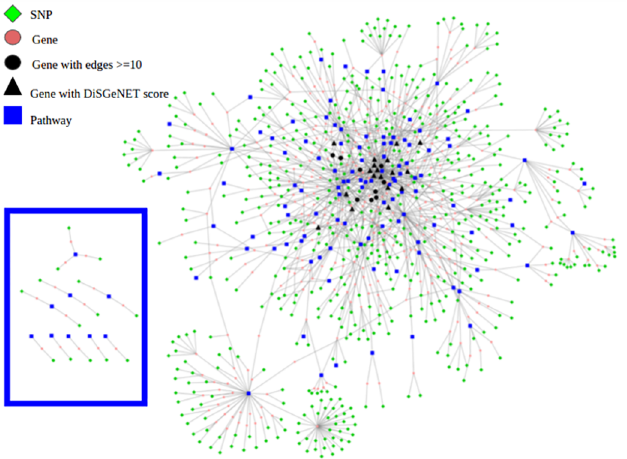
Fig 2. SNP-gene-pathway network. The network displays 580 SNPs (green diamonds) located in the selected region for 365 genes (circles) present in 117 pathway clusters (blue squares). Black symbols indicate genes with ten or more connections to pathway clusters, and triangles indicate genes with a positive DisGeNET score (note that these are all black). The disconnected SNP-gene-pathway subnetworks are shown on the left, framed in black.